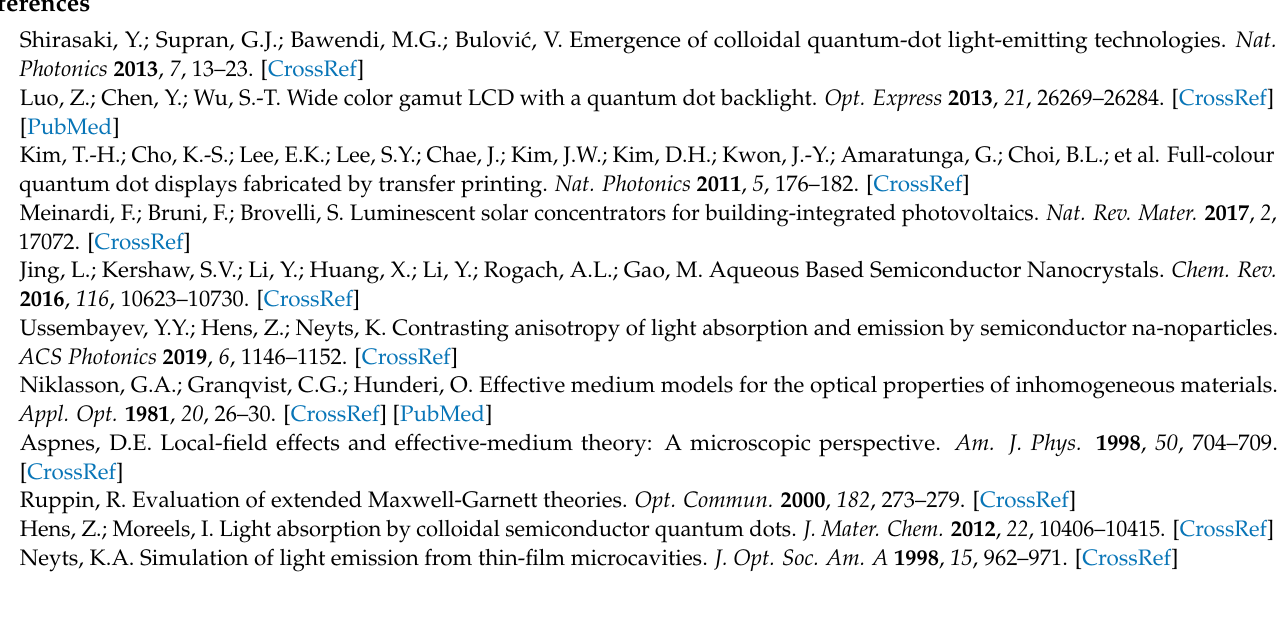
Figure S2: Absorption and effective thickness of packed nanorods, Figure S3: Bright field images of the scratch, Figure S4: Imaging through a slit for SPCM scanning, Figure S5: CMOS intensity profiles of the images in Figure 8, Video SI: waveguiding through the